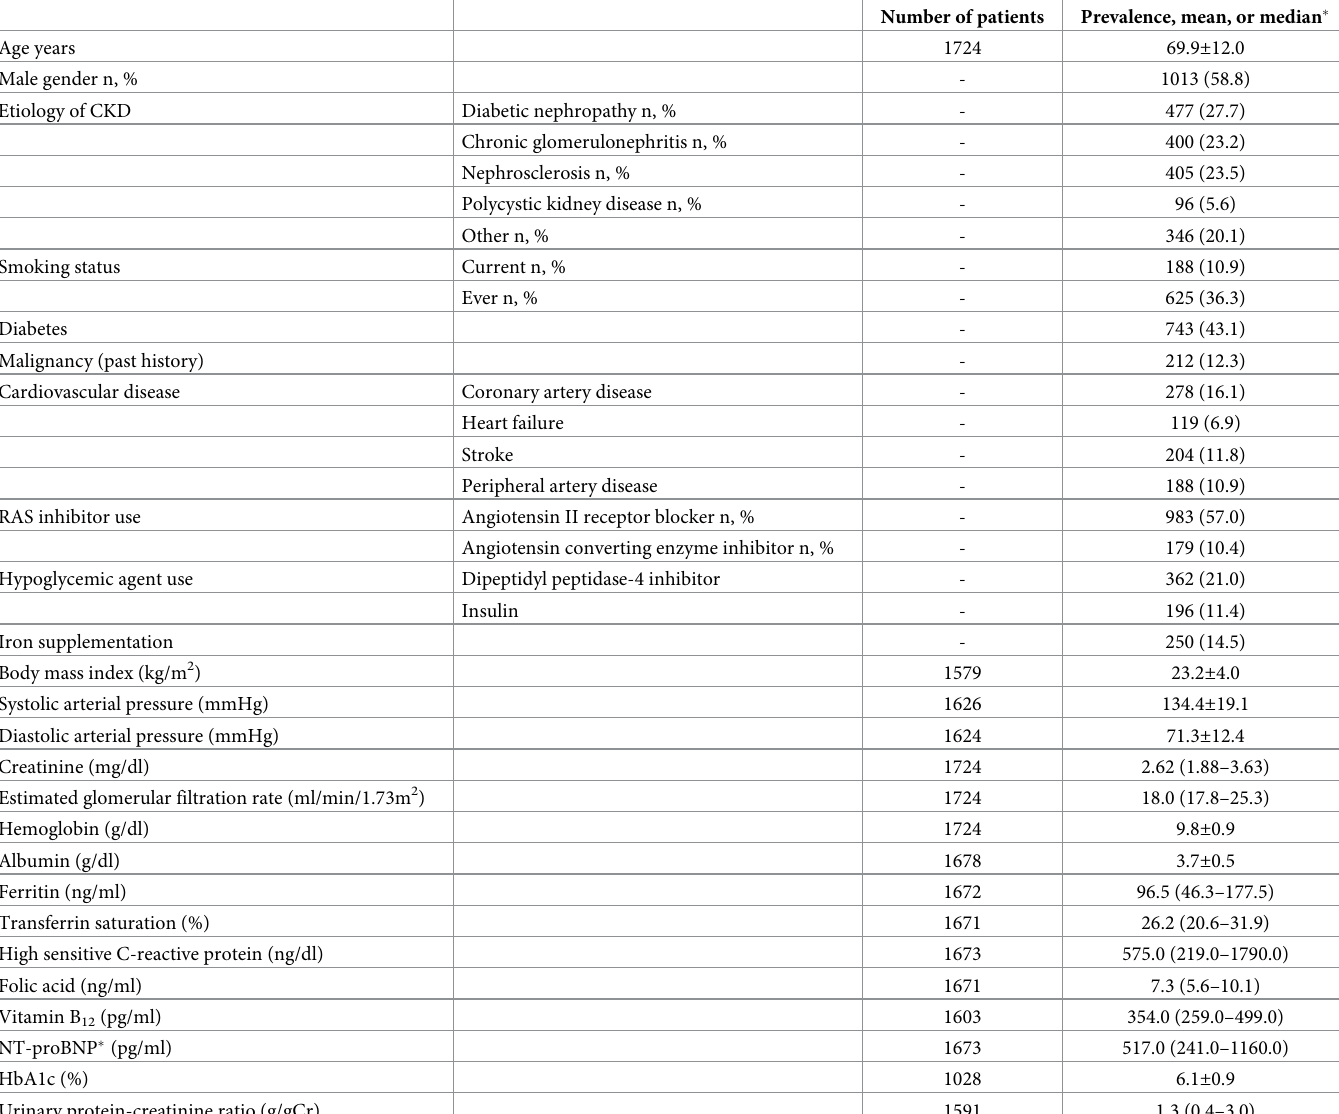
Table 1. Baseline